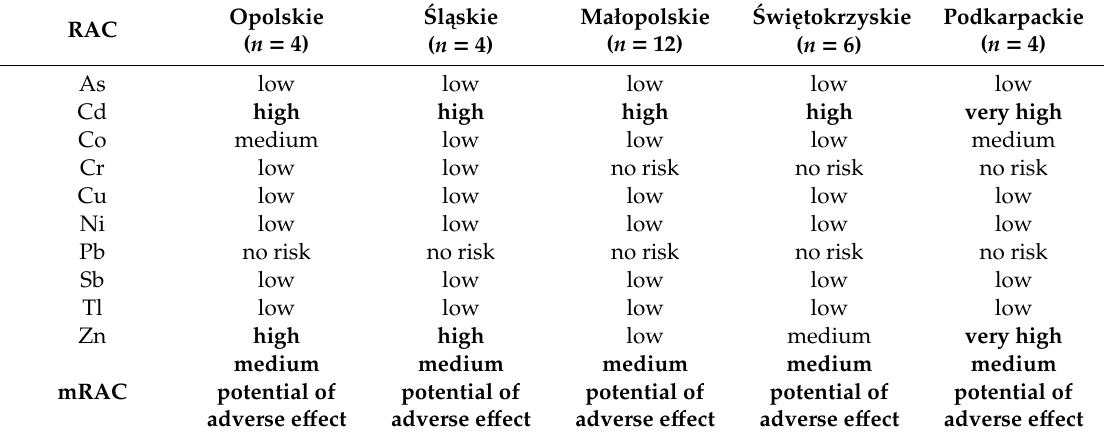
Table 6. Ecological risk of PHEs in soils, according to the risk assessment code (RAC) and modified RAC (mRAC) indices.